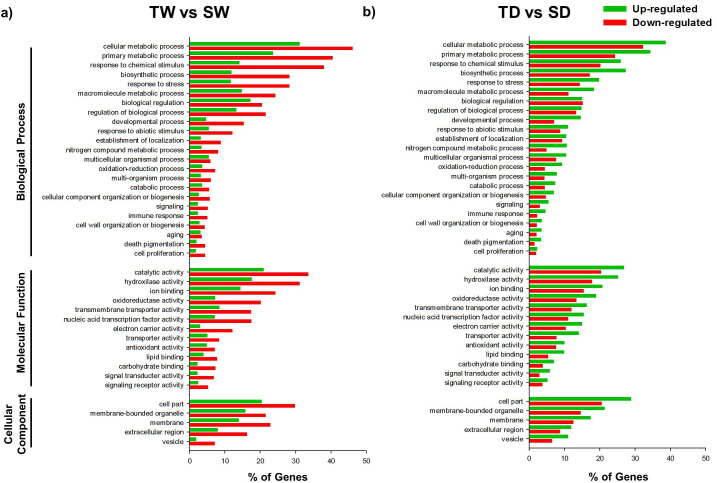
Gene Ontology Functional annotation of DEGs in TW vs SW and TD vs SD treatments.GO Slim terms for Biological Process, Molecular Function, and Cellular Component assigned to up-regulated and down-regulated genes (%) from both C. papaya genotypes, when (a) well-watered (TW vs SW); or (b) when both genotypes were subjected to WDS for 14 d.p.t. (TD vs SD). GO associations were assigned by a BLASTX search against A. thaliana proteome.